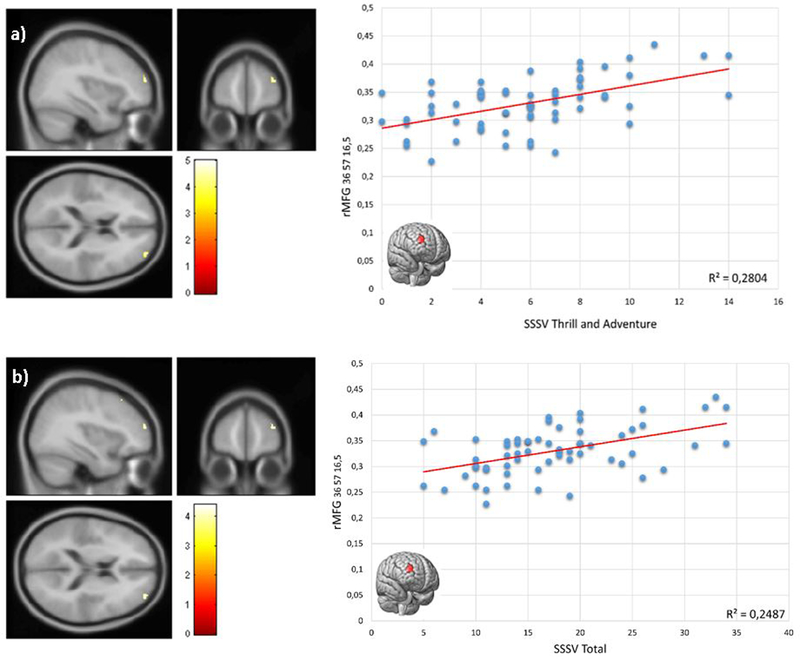
Results of multiple regression analyses. (A) In ALC patients, right MFG was positively correlated with SSSV Thrill and Adventure Score. (B) Right MFG was positively correlated with SSSV Total Score. The significance threshold was set at FWE-corrected p < 0.05. Color scales represent t-scores.